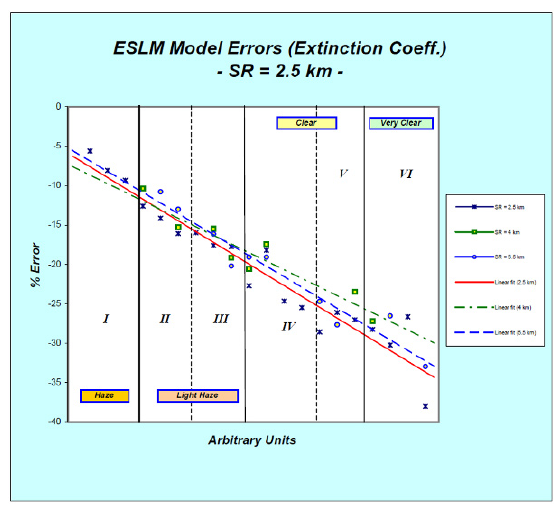
Figure 10. ESLM model errors for computation of γ ( λ = 1064 nm – SR = 2.5 km).